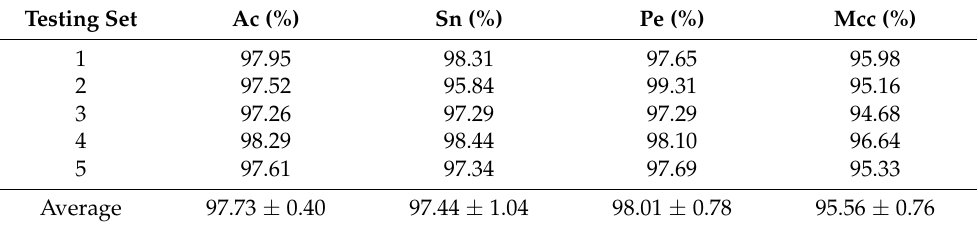
Table 1. 5-fold cross validation results performed by proposed model on an enzyme dataset. Testing Set